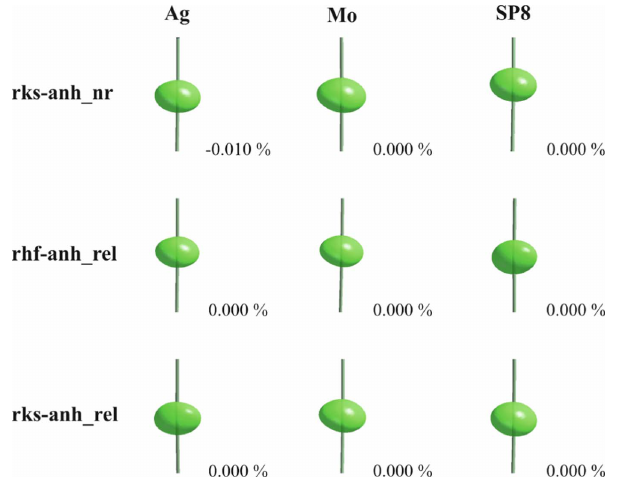
Figure 4 Graphical representation of the total probability density function of the gold atom at the 90% probability level for all anharmonic refinements considered. The percentage values denote total integrated negative